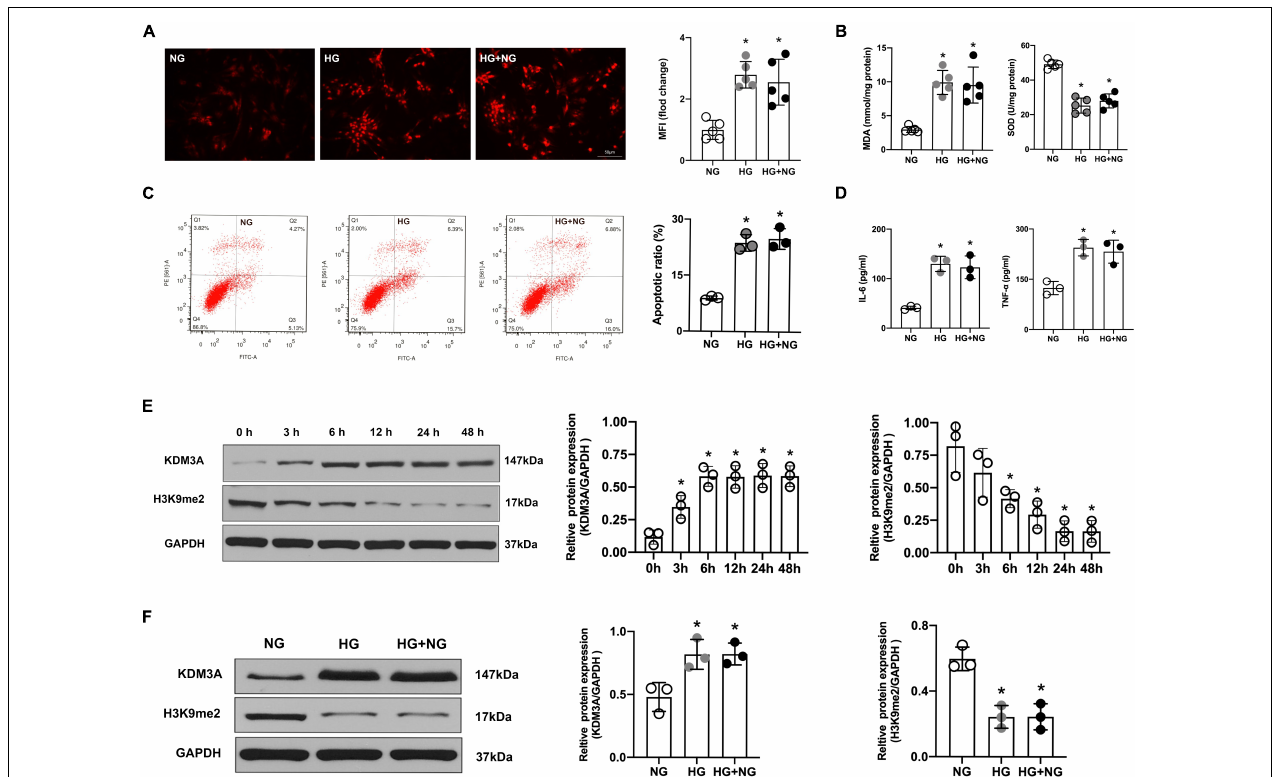
FIGURE 1 | High glucose-induced cardiomyocyte dysfunction persist even after glucose levels were normalized, accompanied by the over-expression of KDM3A. (A) ROS generation was detected by the DHE method, and the MFI was a quantitative indicator for analysis ( n = 5, * p < 0.05, as compared to the NG group). (B) The MDA content and SOD activity of cell lysate were assessed simultaneously ( n = 5, * p < 0.05, as compared to the NG group). (C) The apoptosis of cardiomyocytes in different groups was tested by flow cytometry ( n = 3, * p < 0.05, as compared to the NG group). (D) The inflammatory factors IL-6 and TNF- α in cardiomyocytes of each group were measured by ELISA kits ( n = 3, * p < 0.05, as compared to the NG group). (E) At the cellular level, the protein expression of KDM3A and H3K9me2 were detected with HG treatment from 0 to 48 h ( n = 3, * p < 0.05, as compared to the 0 h group). (F) The protein levels of KDM3A and H3K9me2 in cardiomyocytes of NG, HG, and HG–NG the group were measured by western blot ( n = 3, * p < 0.05, as compared to the NG